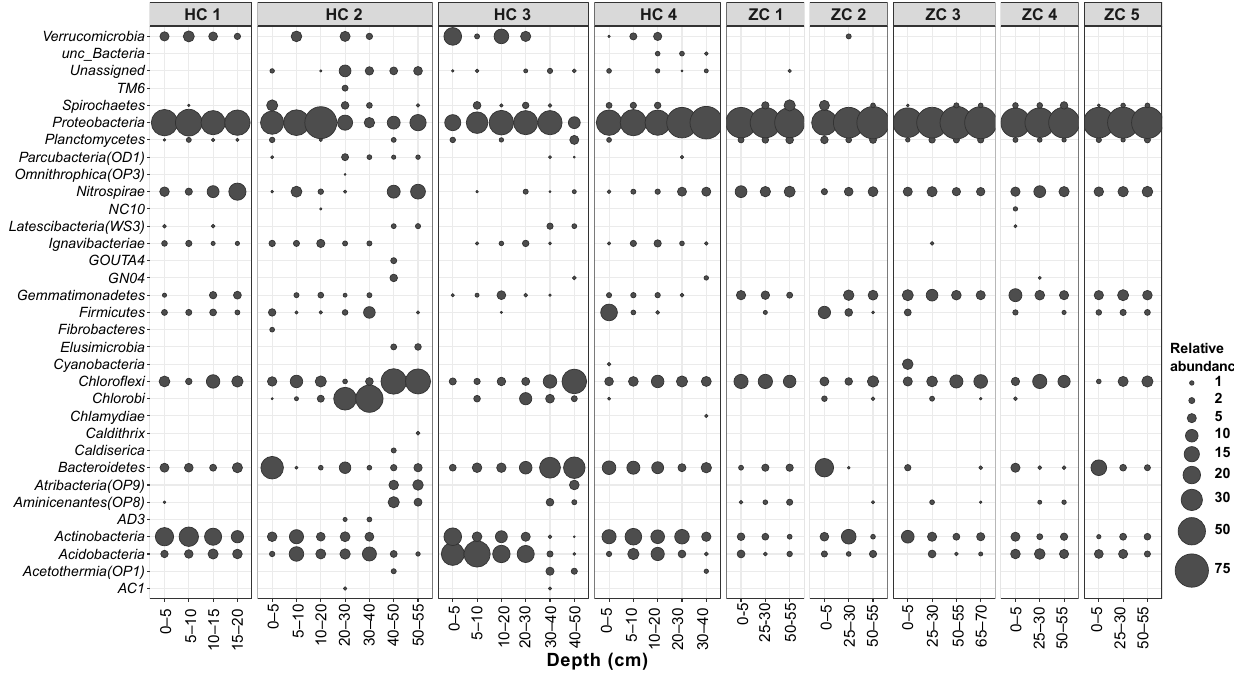
Figure 3. Relative abundances of different bacterial lineages in the study sites. Along the horizontal axis samples are arranged according to site and depth. The rank order along the vertical axis is shown for the phylum